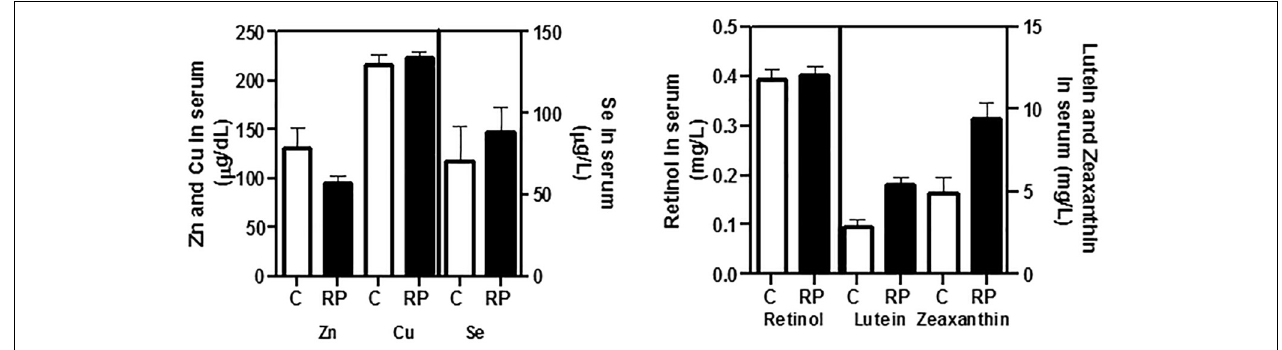
FIGURE 2 | Baseline concentrations of antioxidant nutrients in serum of controls and RP patients. Retinol, vitamin B6, folic acid (vitamin B9), lutein, and zeaxanthin were determined by ultra high performance liquid chromatography (UHPLC). Vitamins B6 and B9 were not detectable by UHPLC in the samples. Trace elements zinc (Zn), copper (Cu), and selenium (Se) were determined with fluorometric commercial kits. All data were plotted in bar graph with standard error bars. C, control subjects; RP, patients with retinitis pigmentosa.